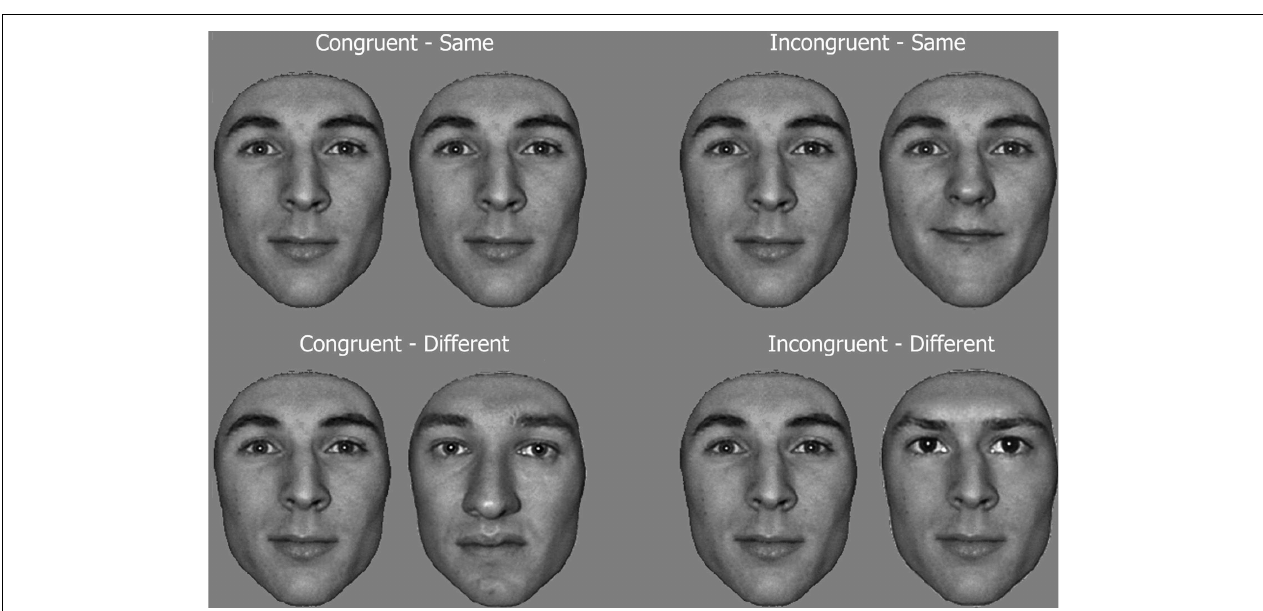
and mouth). In congruent conditions, both the target and distracter features lead to an identical decision, while they call for opposite responses in incongruent